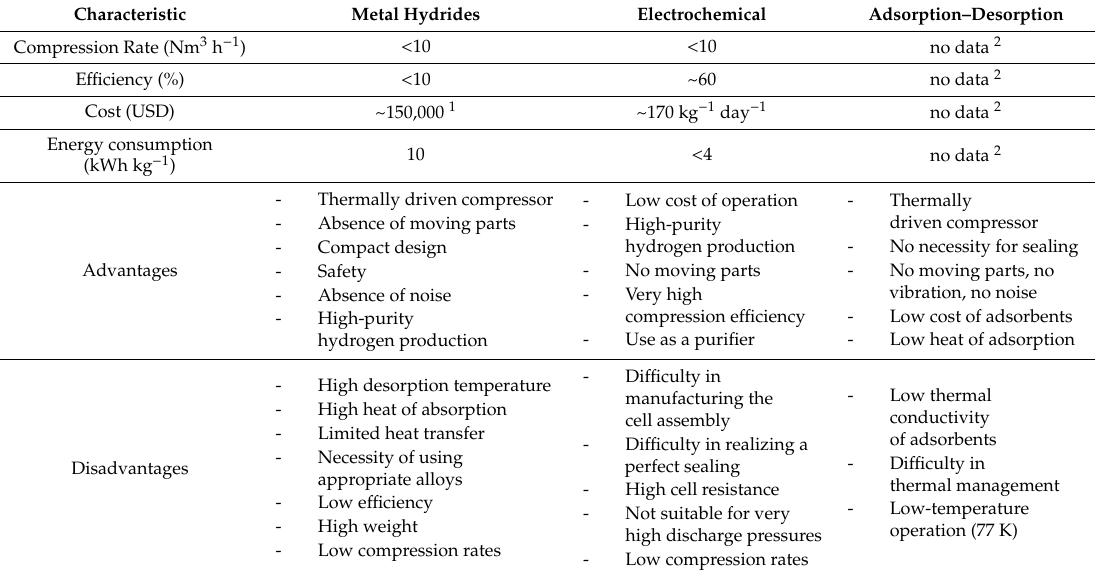
Table 2. Main characteristics of non-mechanical hydrogen compressors.